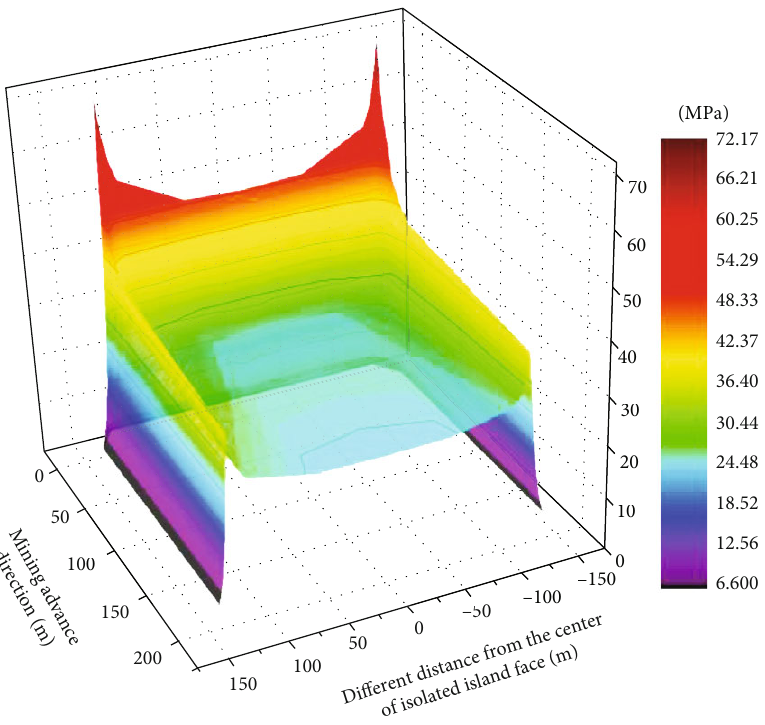
Figure 10: Characteristics of the distribution of advance mining stress in the isolated coal